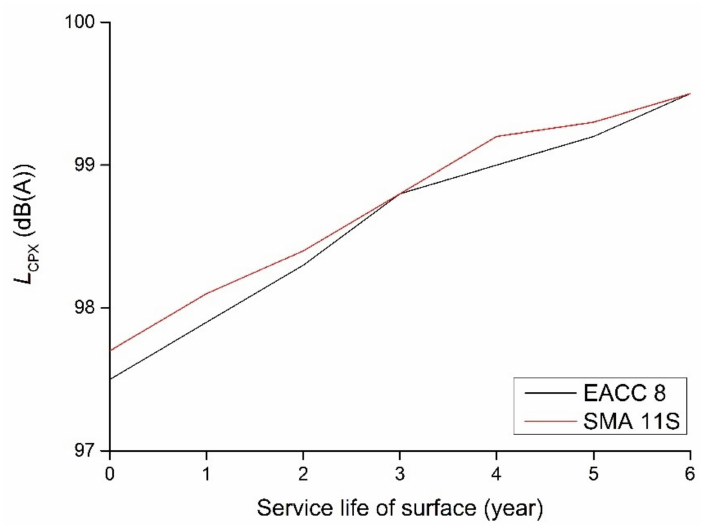
Figure 12. Comparison of the noise levels development of the EACC 8 and SMA 11S surfaces on the monitored motorway